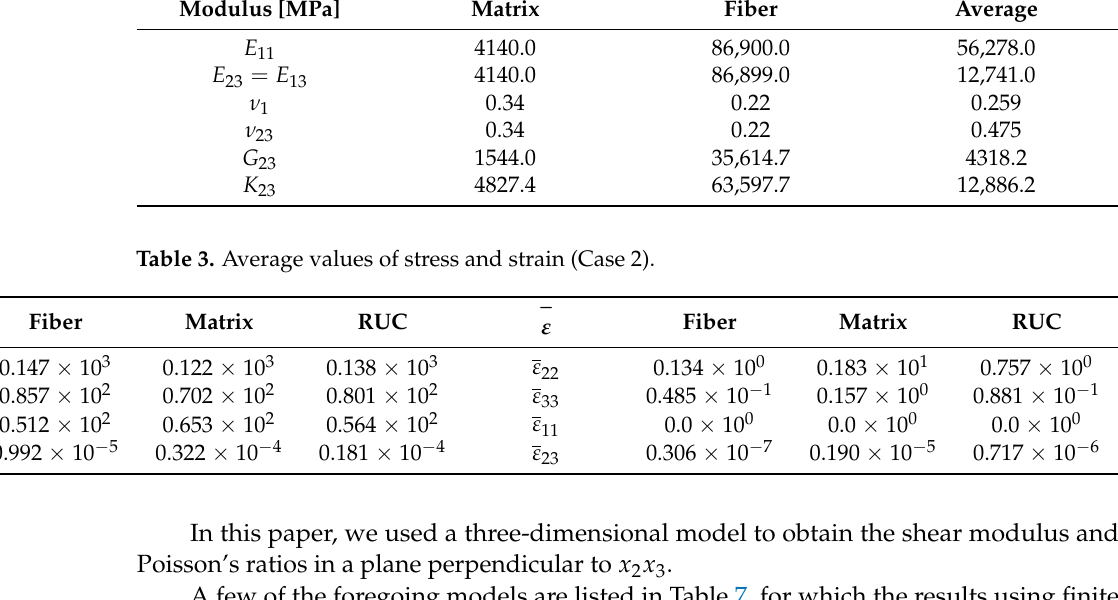
Figure 7. Finite element model 2 for a RUC.